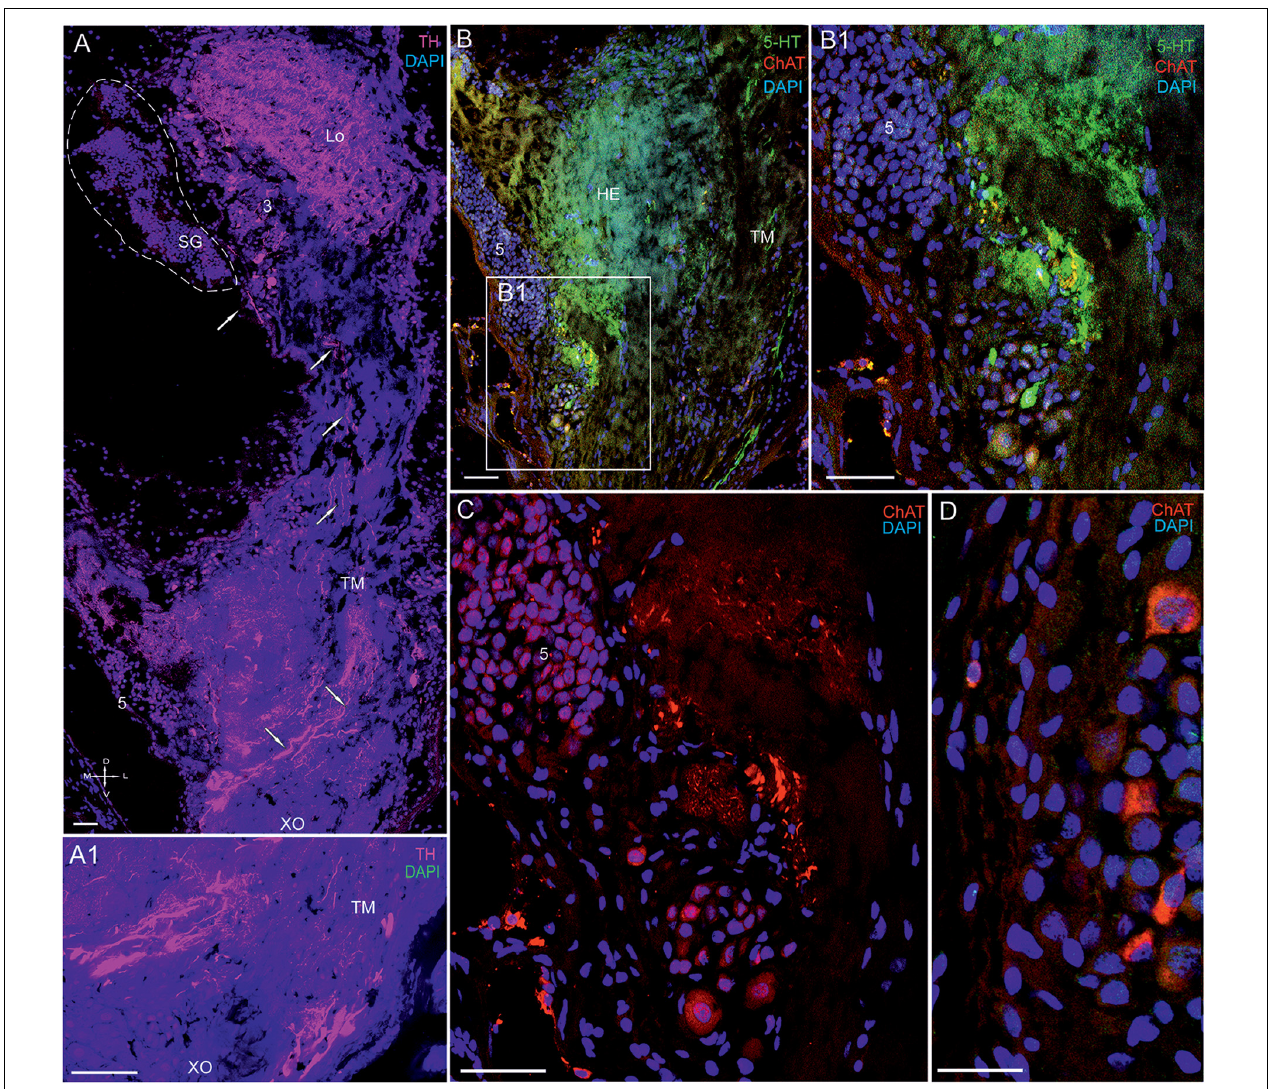
FIGURE 11 | Immunolocalization of 5-HT, TH, and ChAT in the lateral protocerebrum of Paralithodes camtschaticus . (A,A1) Tissue section through the eyestalk of P. camtschaticus showing TH-positive immunostaining in the Lo and LP. (A1) Regions of the XO showing strong TH immunostaining. (B) TH-positive processes in the LP near the cells of cluster 5 and regions of the TM. (B1–D) 5-HT- and ChAT-positive neurons and processes near cell cluster 5. TH-positive immunostaining in optic neuropils and the LP. Scale bars = 100 µ m. Lo, lobula; 5, cell cluster; LP, lateral protocerebrum; TM, terminal medulla; HE, the hemiellipsoid body; D, dorsal; V, ventral; L, lateral; M, medial; A, anterior; P,